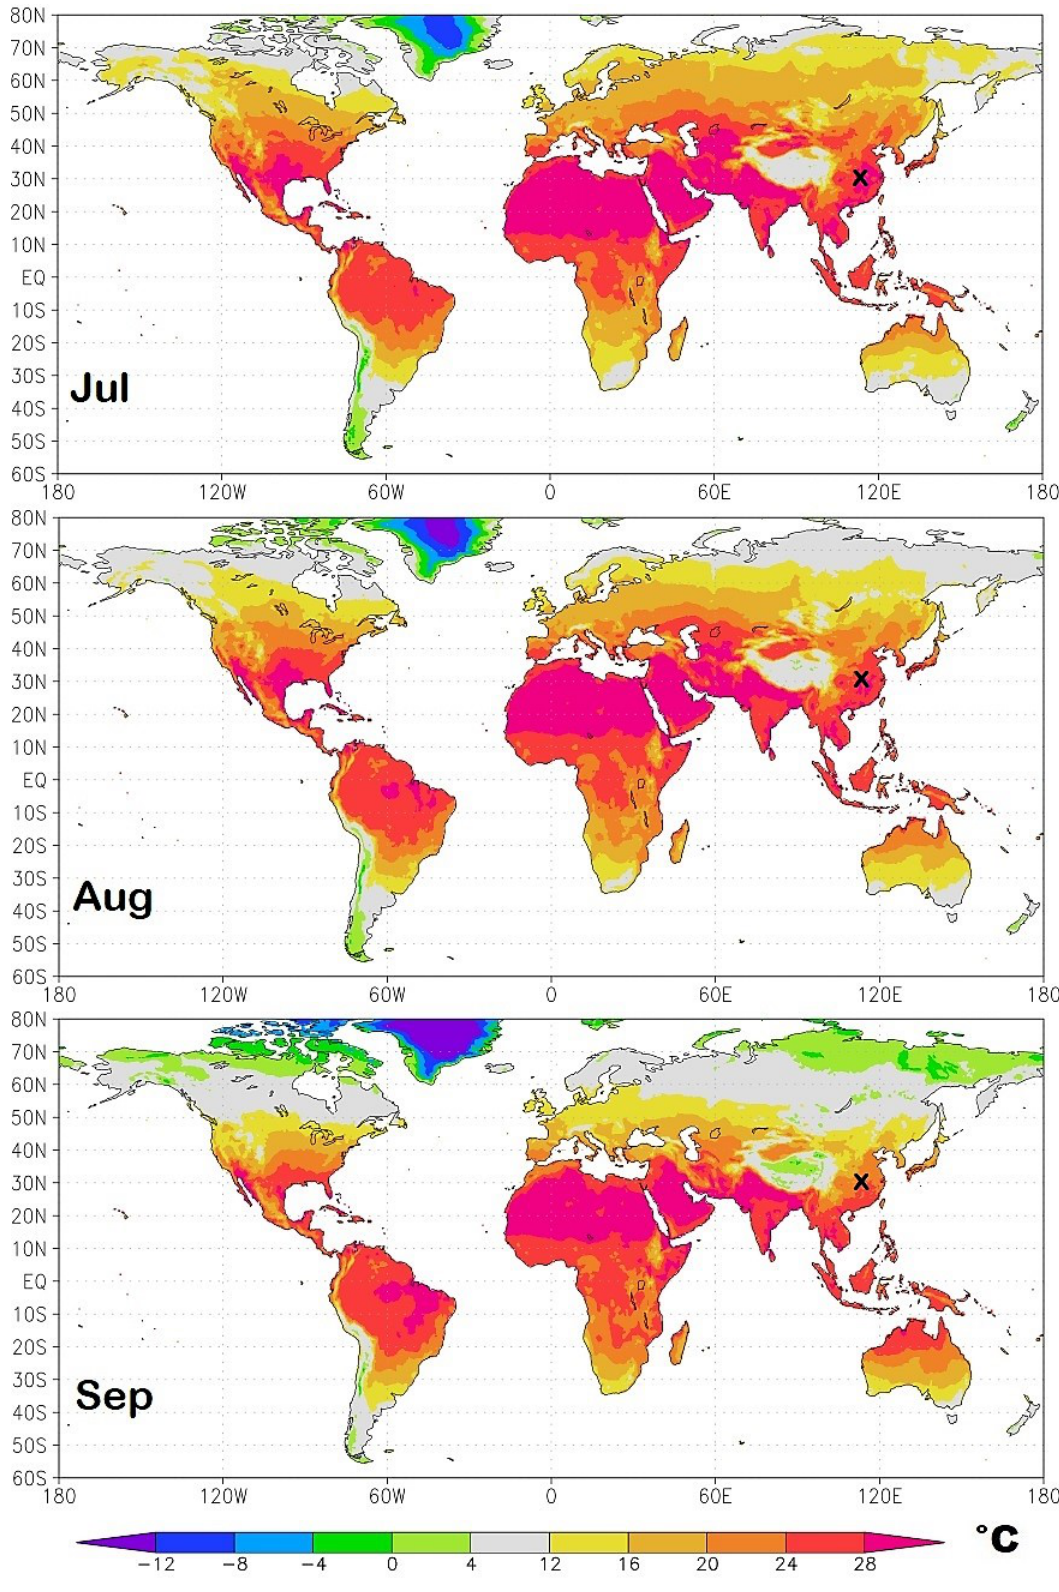
Figure 13. Summer isotherm world maps from July to September. The small x over China indicates the position of Wuhan. The light-gray zone represents the modeled most exposed regions to the COVID-19